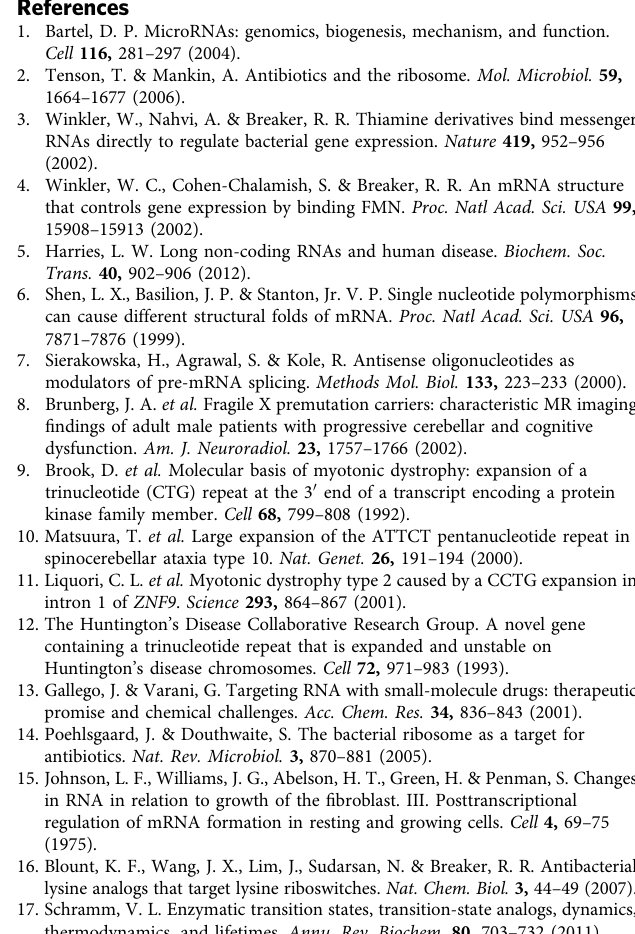
Cell culture of SCA10 fibroblasts . SCA10 fibroblasts 33 were cultured in MEM with Eagle–Earle salt and 2mM L -glutamine containing 15% fetal bovine serum and antibiotic in 5% CO 2 at 37 (cid:2) C in 75-cm 2 flasks. Compounds were dissolved in 50% DMSO and added to the SCA10 cells at the indicated concentrations. Fresh medium with drug was added to the cells after every 12h and cells were collected after 48h for the caspase-3 assay, detection of AUUCU RNA foci, or for analysing the subcellular translocation of protein kinase C d (PKC d